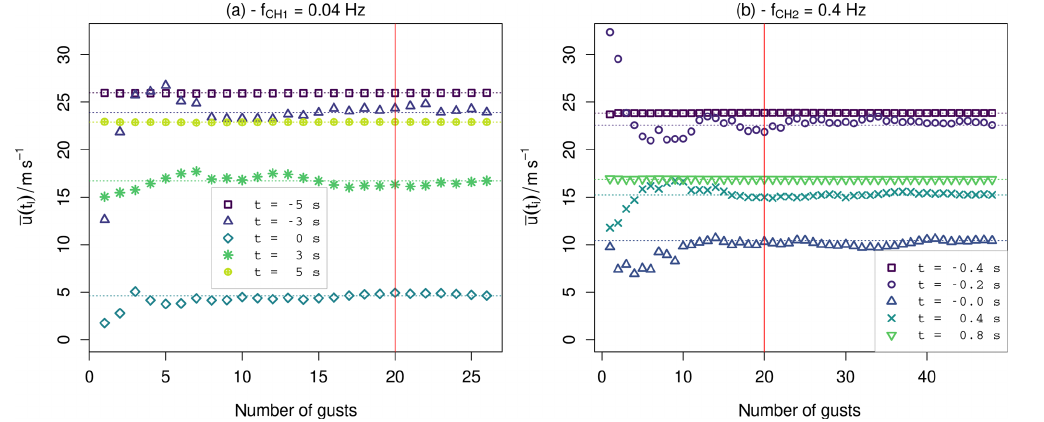
Figure 2. Convergence test of the phase average at five different points of time during the gust event for a data set measured at the centerline at X = 3 . 475 w CH and the two chopper frequencies f CH